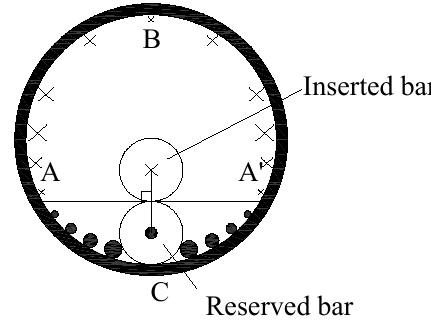
Figure 24. Distribution of the longitudinal bonding stress between the middle section of the sleeve and the grouting material along the sleeve.